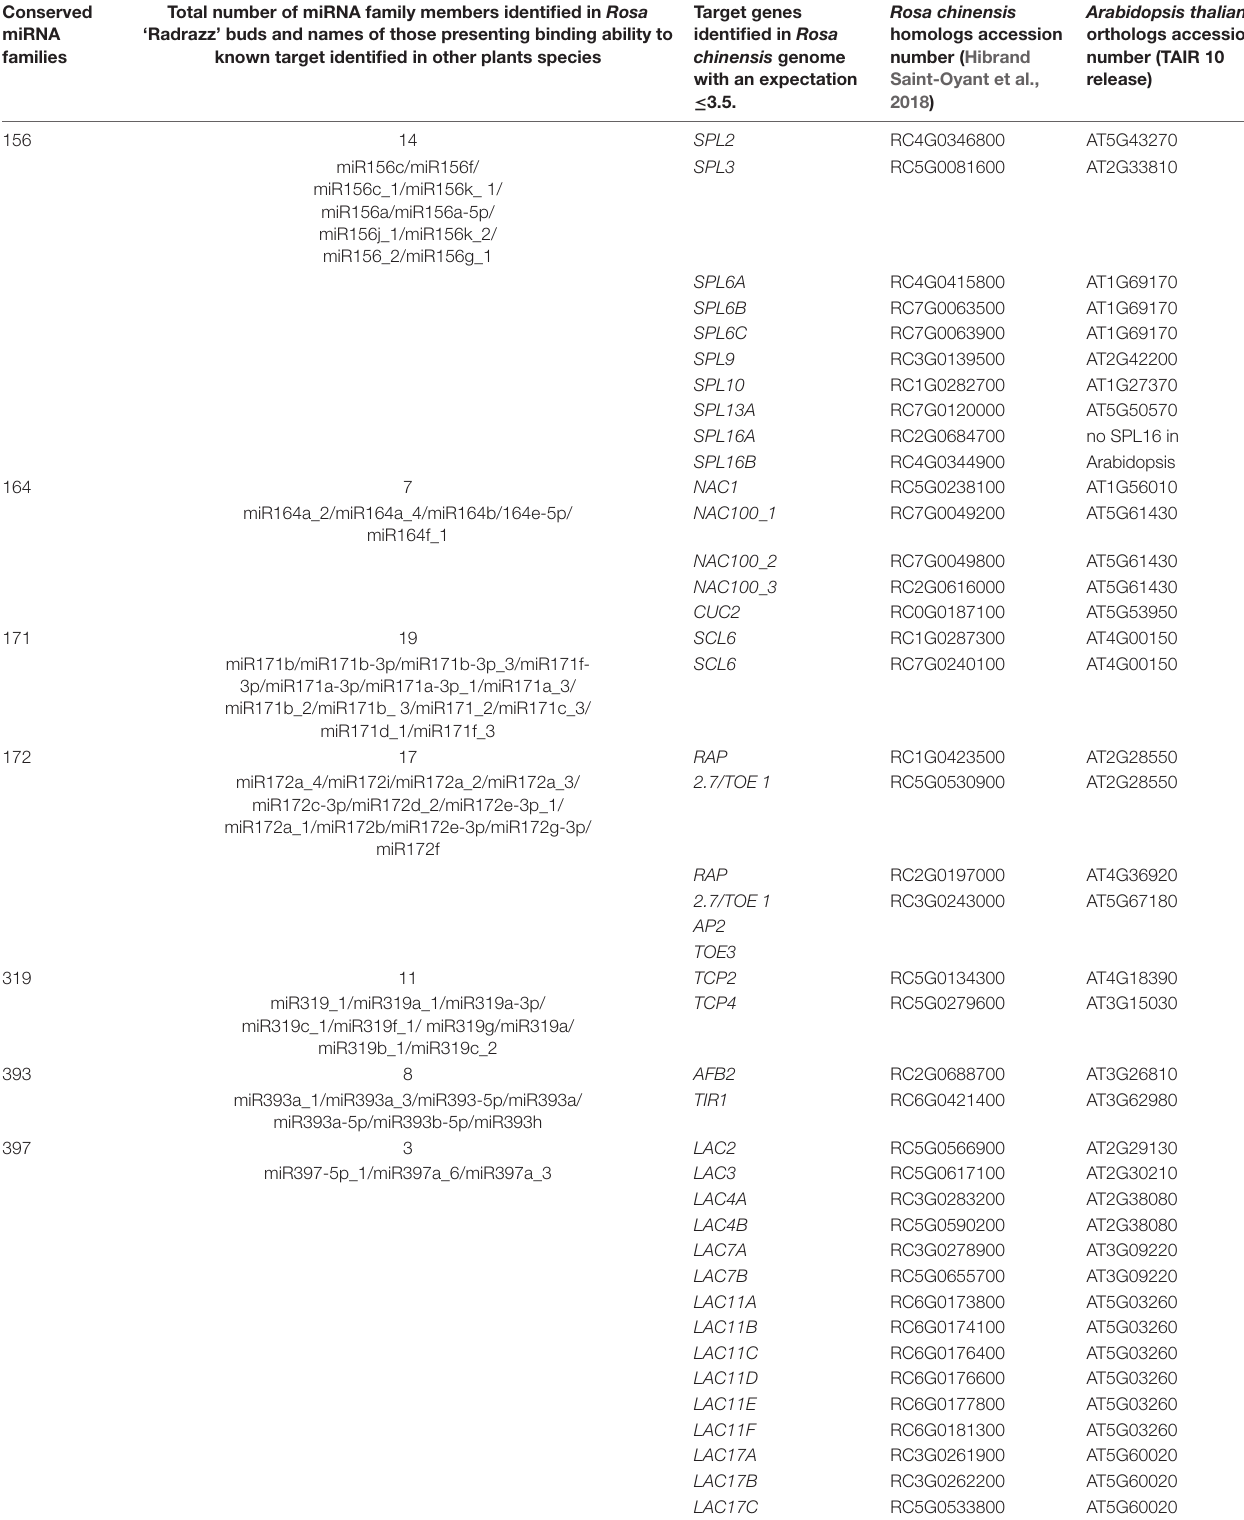
TABLE 2 | Conserved miRNAs expressed in Rosa ‘Radrazz’ buds and their predicted gene targets. Conserved miRNA